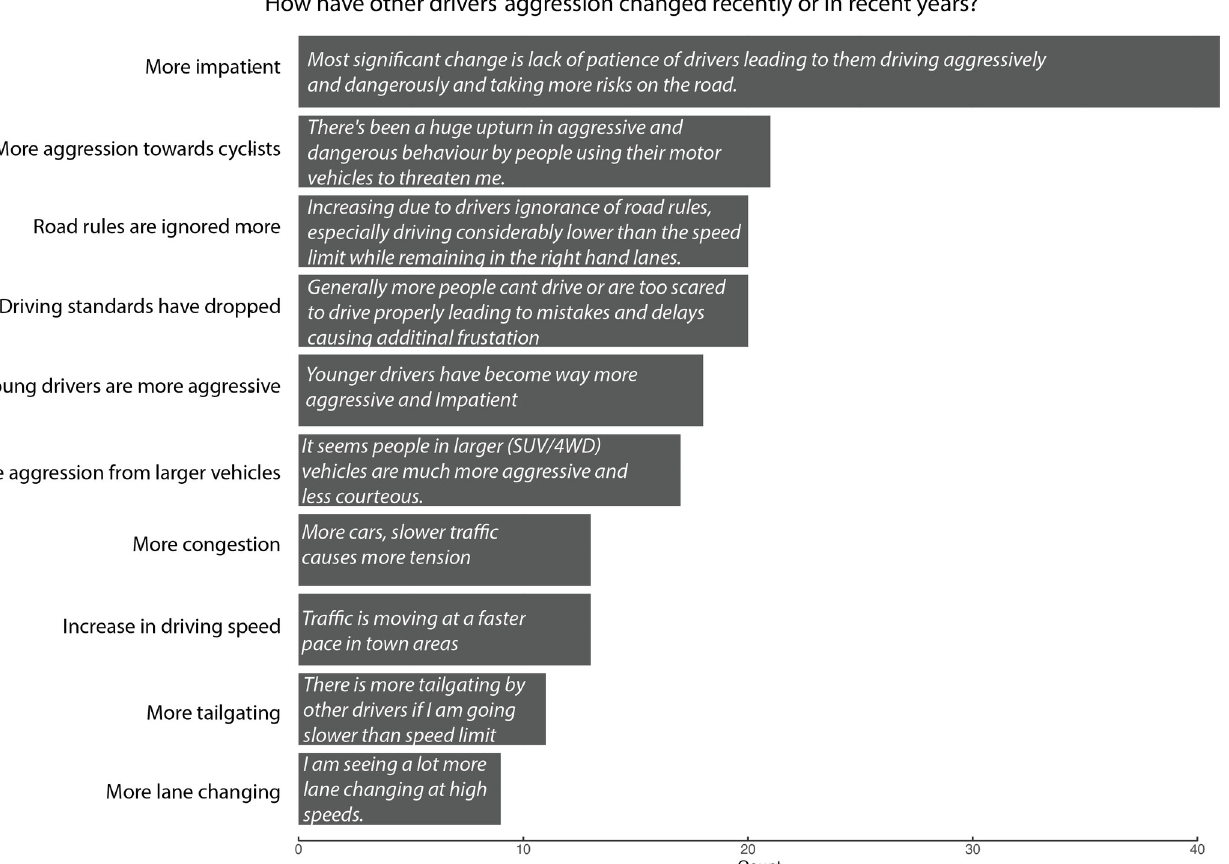
PLOS ONE | https://doi.org/10.1371/journal.pone.0272422 August 1,